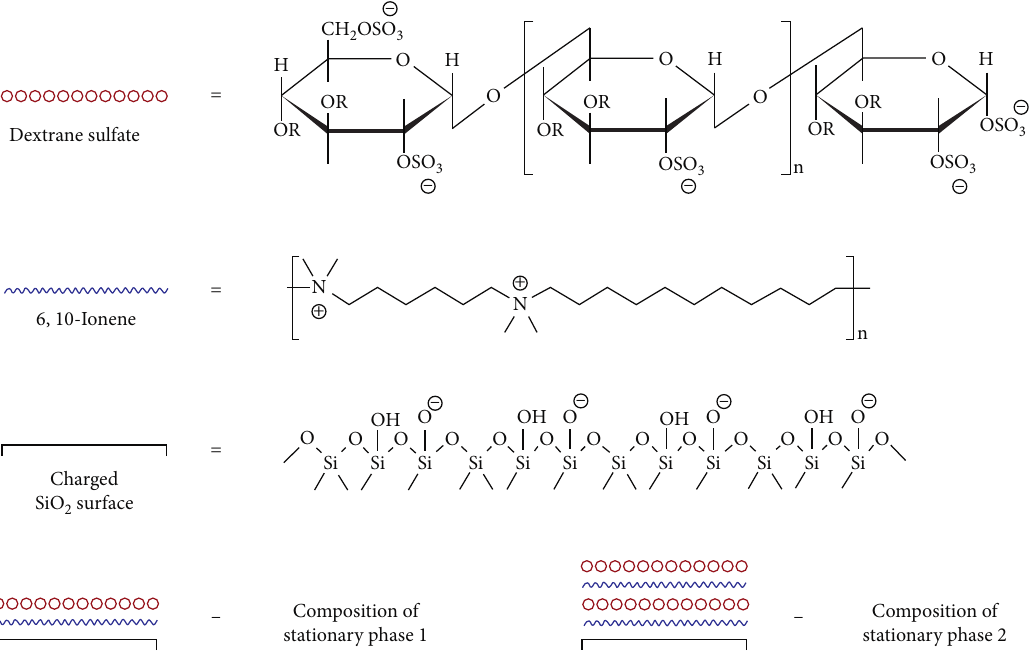
Figure 2: General structures of SP-1 and SP-2.